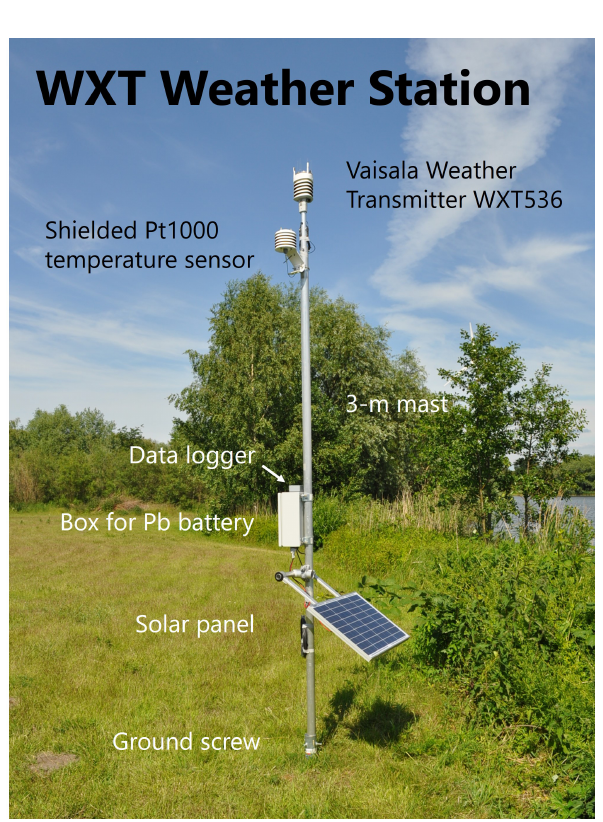
Figure 4. Components of WXT weather